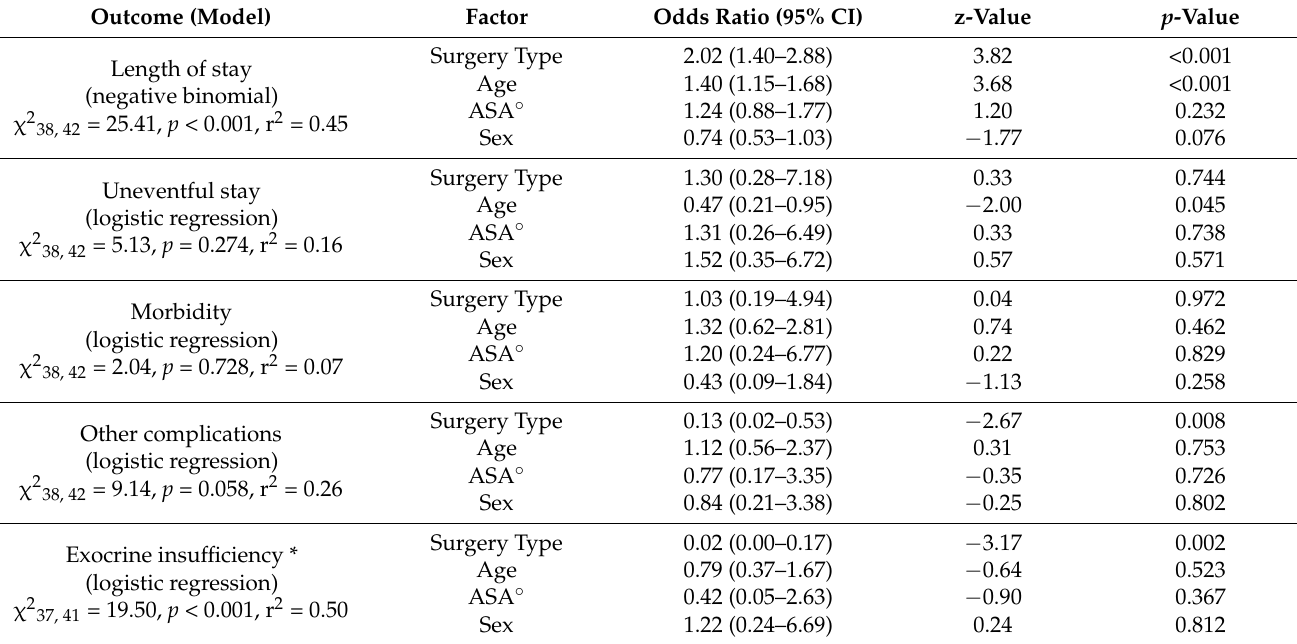
Table A9. Model results for the effects of surgery type (TP vs. MPP) and patient characteristics of age and ASA ◦ ( ≤ 2 vs. >2) on postoperative outcomes.